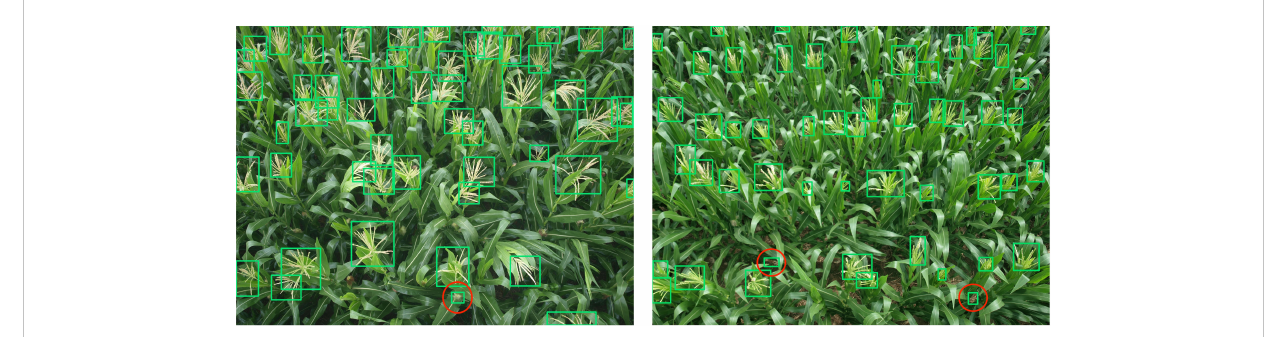
FIGURE 10 Interference from weeds and maize silks in the accurate detection of maize tassels (red circles indicate false detection).